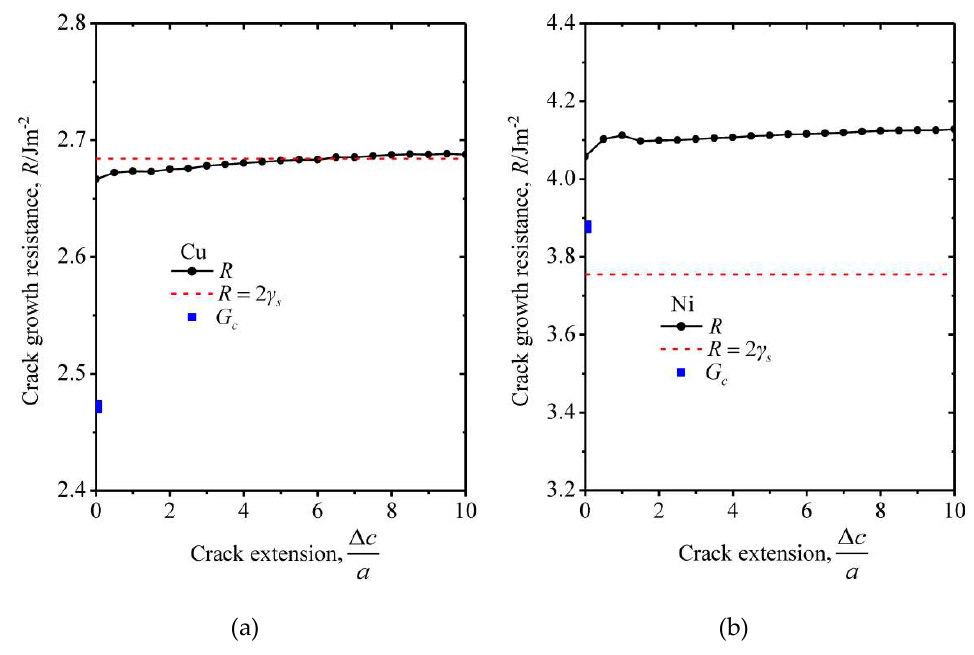
Figure 8. ( a ) R -curve of the Cu nanoplate with a crack length of 25 c . ( b ) R -curve of the Cu nanoplate with a crack length of 25 c . Δ c is the amount of crack growth. For comparison, the critical strain energy release rate at the onset of crack propagation ( G c ) and the fracture toughness predicted by the Griffith criterion (2 γ s ) are inserted.